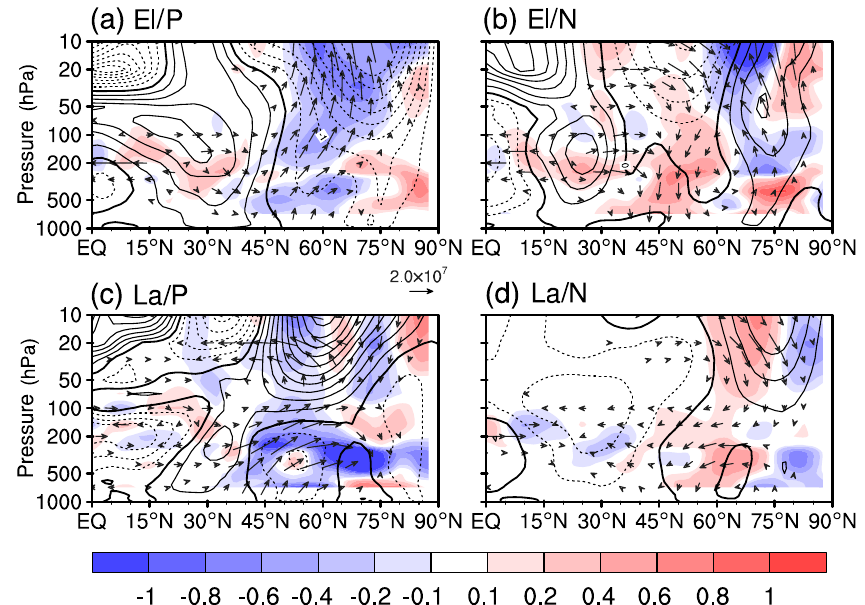
Figure 6. Pressure–latitude cross-sections of composite zonal mean zonal wind anomalies (contours; units: m s − 1 ; interval: 0.5), composite E–P flux anomalies (vectors; units: m 3 s − 2 ; normalized by local air density for clarity), and composite E–P flux divergence anomalies (shadings; units: m s − 1 d − 1 ) during El Niño winters when the PDO is in its ( a ) positive and ( b ) negative phases and those during La Niña winters when the PDO is in its ( c ) positive and ( d ) negative phases.